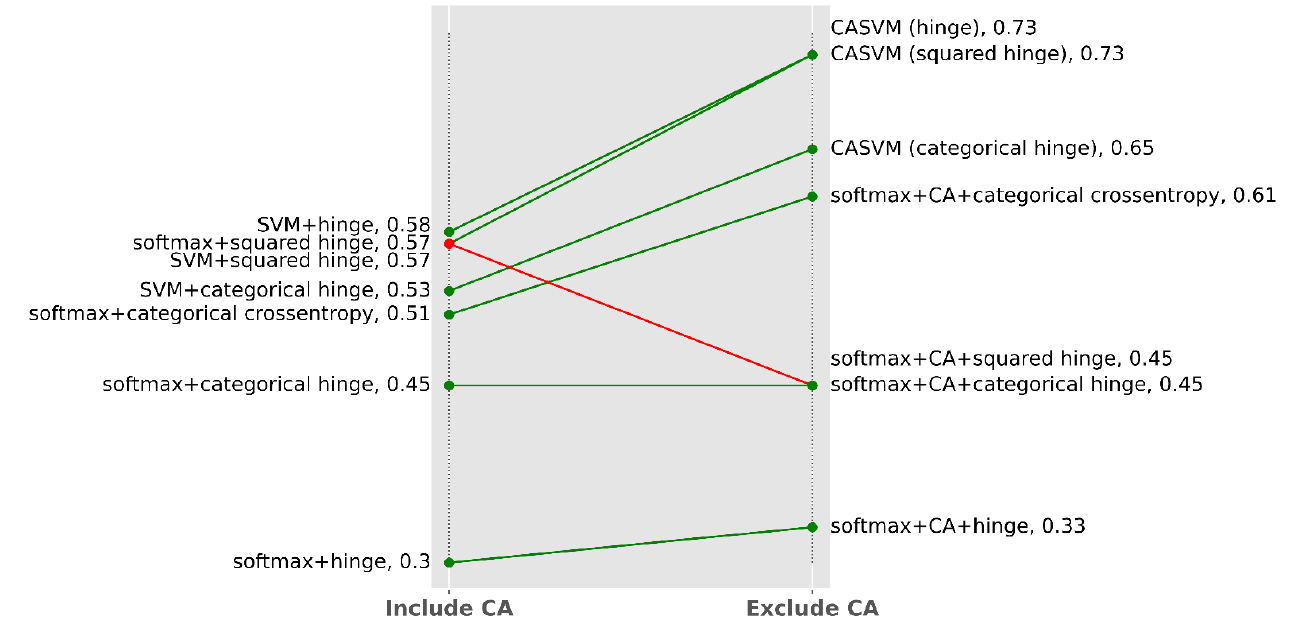
Figure 6. Performance improvement of attention mechanism in network model with different loss functions and two classifiers.